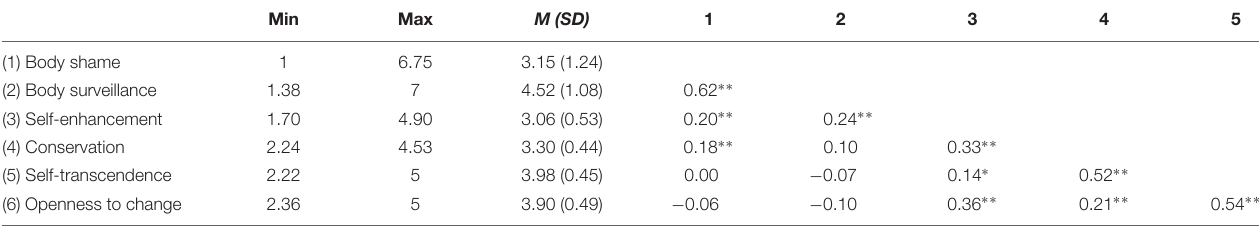
TABLE 1 | Descriptive analyses and correlations of the studied variables.